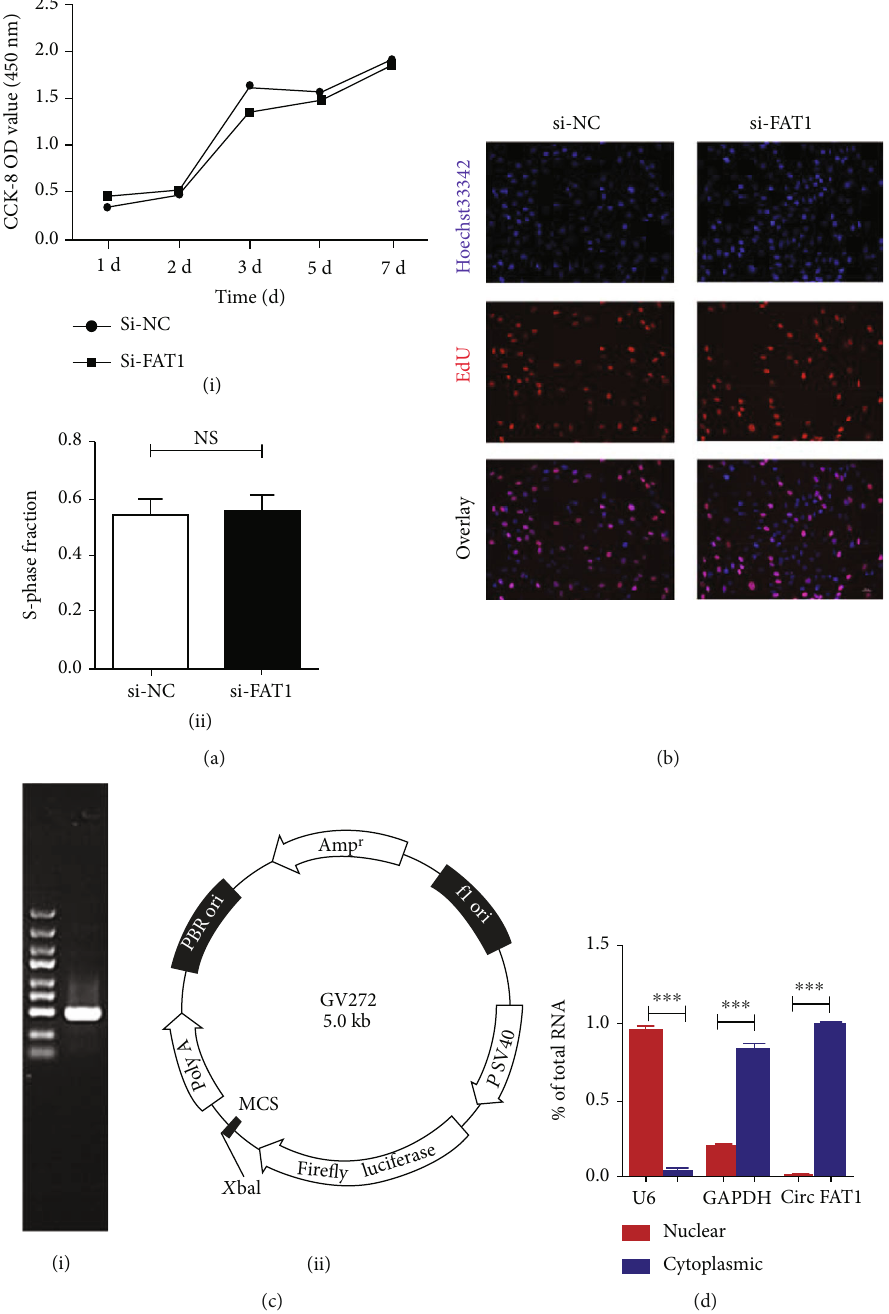
Figure 2: circFAT1 does not a ff ect PDLSCs proliferation. (a) Cell proliferation capability in fl uenced by circFAT1 was detected at 450nm with CCK-8 assay. (I): CCK-8 results showed that circFAT1 had no signi fi cant e ff ect on the proliferation of PDLSCs; (II): EdU assay further con fi rmed that circFAT1 had no signi fi cant e ff ect on the proliferation of PDLSCs. (b) EdU-positive PDLSCs in fl uenced by circFAT1 were detected by EdU kit (scale bar: 200 μ m). EdU (red), Hoechst333 (blue). (c) PCR gel electrophoresis veri fi ed that the primers were located at a single band of 449kb. The cyclization site of circFAT1 was determined by plasmid vector construction. (d) RNA nucleocytoplasmic isolation experiments veri fi ed that circFAT1 was mainly located in the cytoplasm of cells. ∗ P < 0 : 05 , ∗∗ P < 0 : 01 , and ∗∗∗ P < 0 : 001 . EdU: